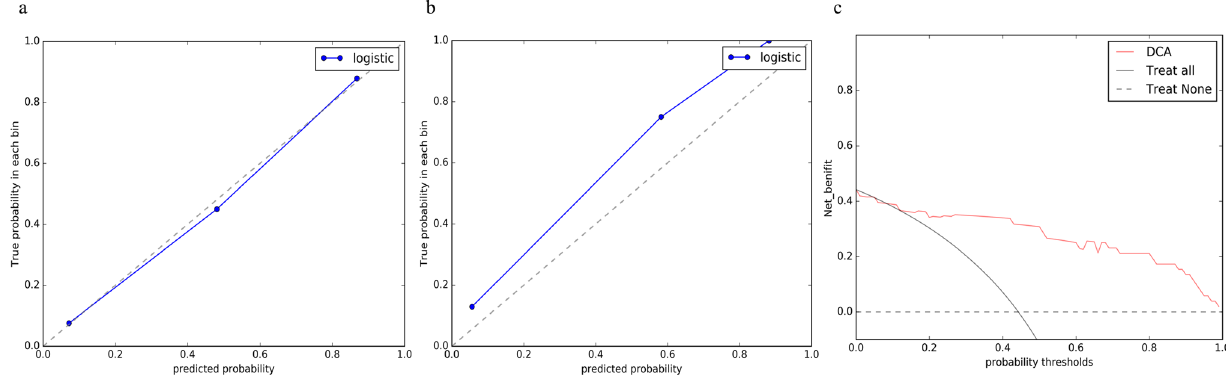
Figure 3. Calibration curves of radiomics model in the training ( a ) and the testing ( b ) groups. The decision curve analyses (DCA) of radiomics model in the testing group ( c